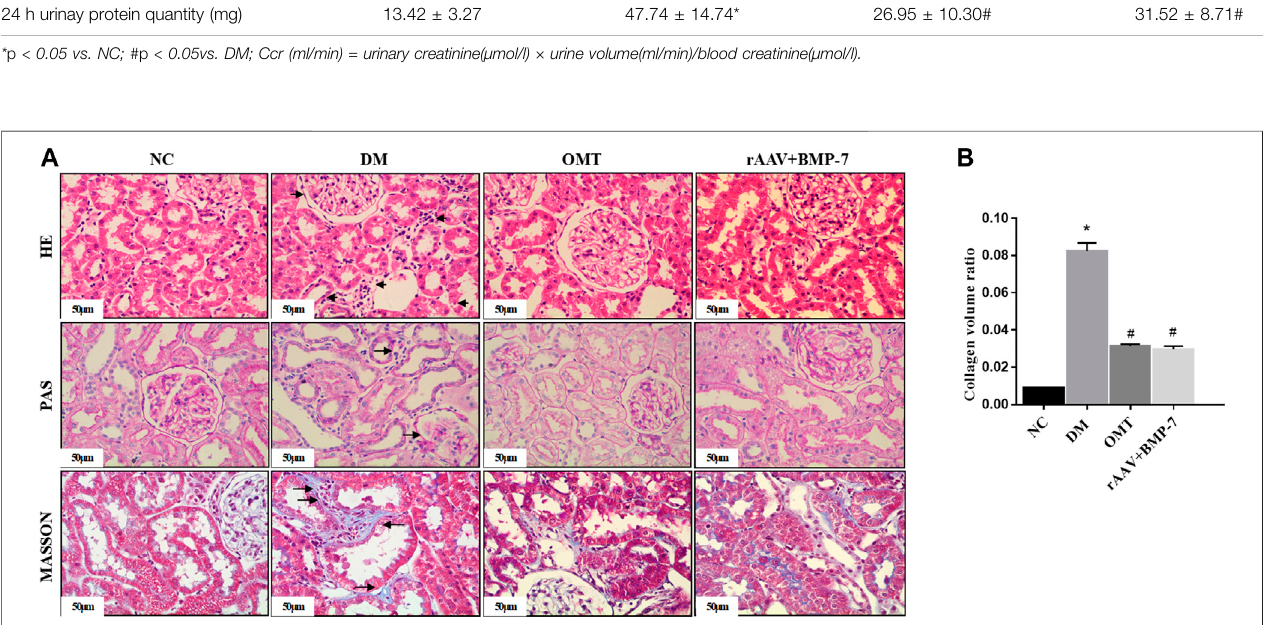
Frontiers in Pharmacology |